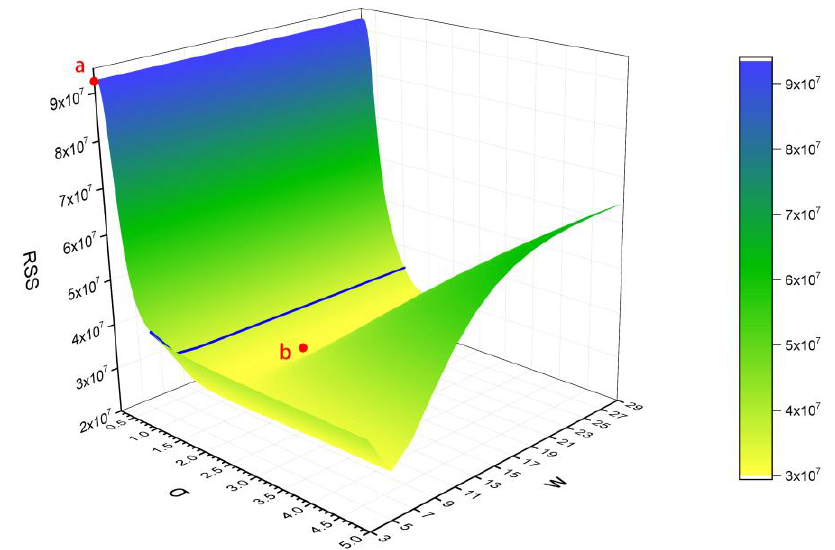
Figure 4. Surface represents the different residual sum of square (RSS) between BiDoseResp-calibrated VIIRS (BDRVIIRS) and DMSP-OLS. Blue line represents the RSS with a normal-distributional filter (σ = 1). Point a represents the RSS without a filter. Point b represents the lowest point of the surface, where σ is 1.51 and w is 15.